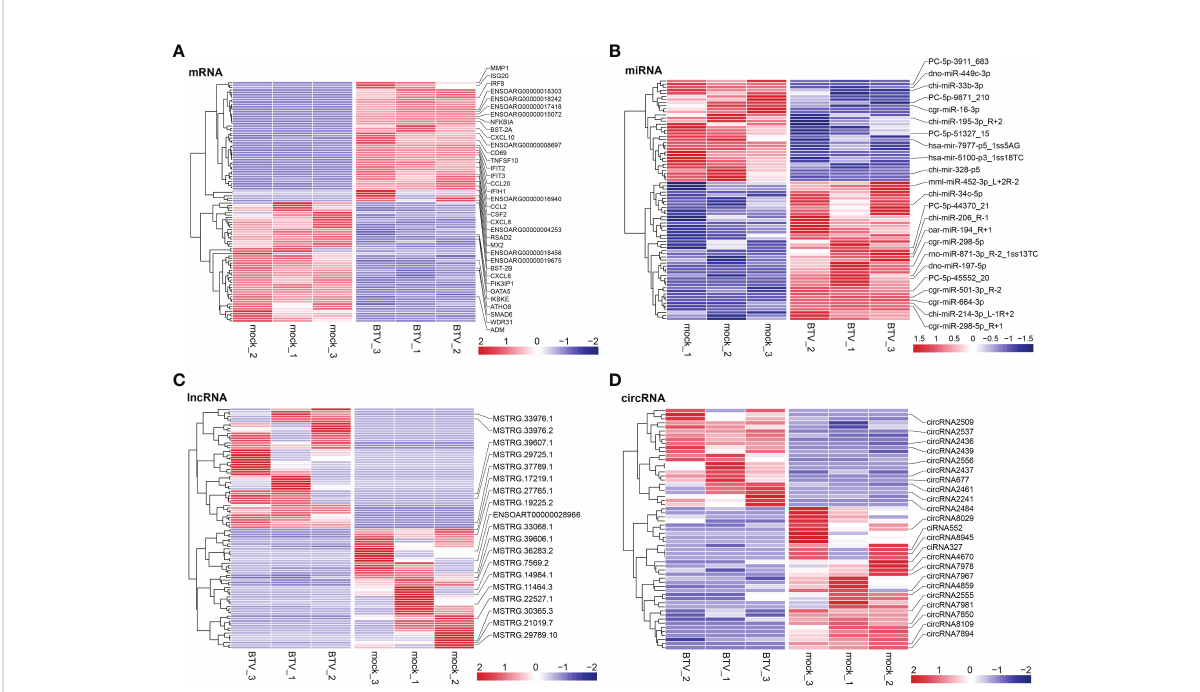
FIGURE 3 Hierarchical cluster analyses of (A) dif-mRNAs, (B) dif-miRNAs, (C) dif-lncRNAs, and (D) dif-circRNAs between BTV-1-infected and mock- infected OA3.Ts cells. The top 50 upregulated and downregulated dif-mRNAs and dif-lncRNAs, as well as all dif-miRNAs and dif-circRNAs were selected and displayed in the heatmaps. The color of the color blocks from blue to red represented the dif-RNAs expression levels from downregulated to upregulated. Several important dif-RNAs were labeled to the right of the corresponding